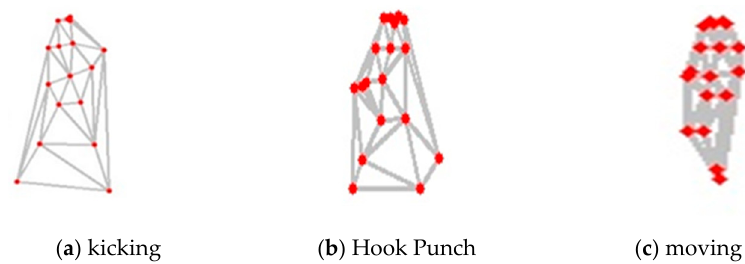
Figure 5. Delaunay triangulation generated from the karate competition video.